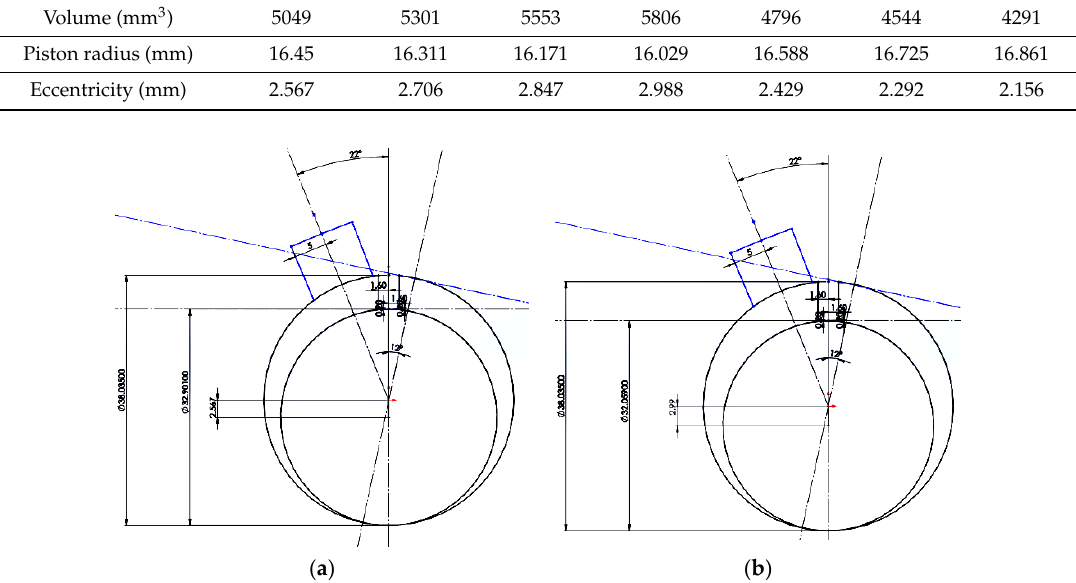
Figure 11. Two different volumes of compressor: ( a ) original type, 2210-45, ( b ) original type with additional 15% of volume.